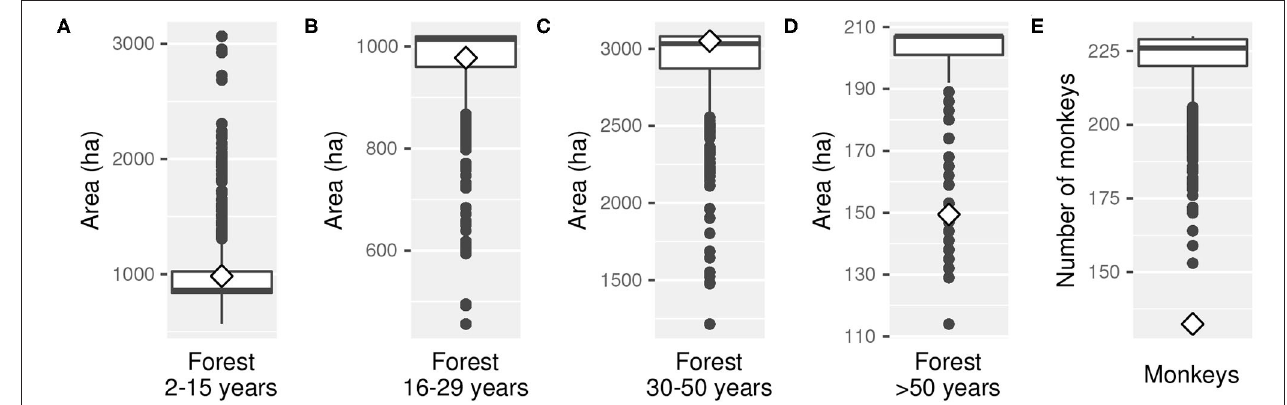
FIGURE 6 | Validation test results. Results of simulations and empirical values for five different variables. (A) Area of forest with successional age between 2 and 15 years. (B) Area of forest with successional age between 16 and 29 years. (C) Area of forest with successional age between 30 and 50 years. (D) Area of forest with successional age > 50 years. (E) Total number of monkeys in the reserve. Boxplots are the model outputs after 12 years (from 2003 to 2015) for 100 simulation runs. Diamonds represent the empirical observed values for different forest types in 2015 and the total estimated number of monkeys in 2015.